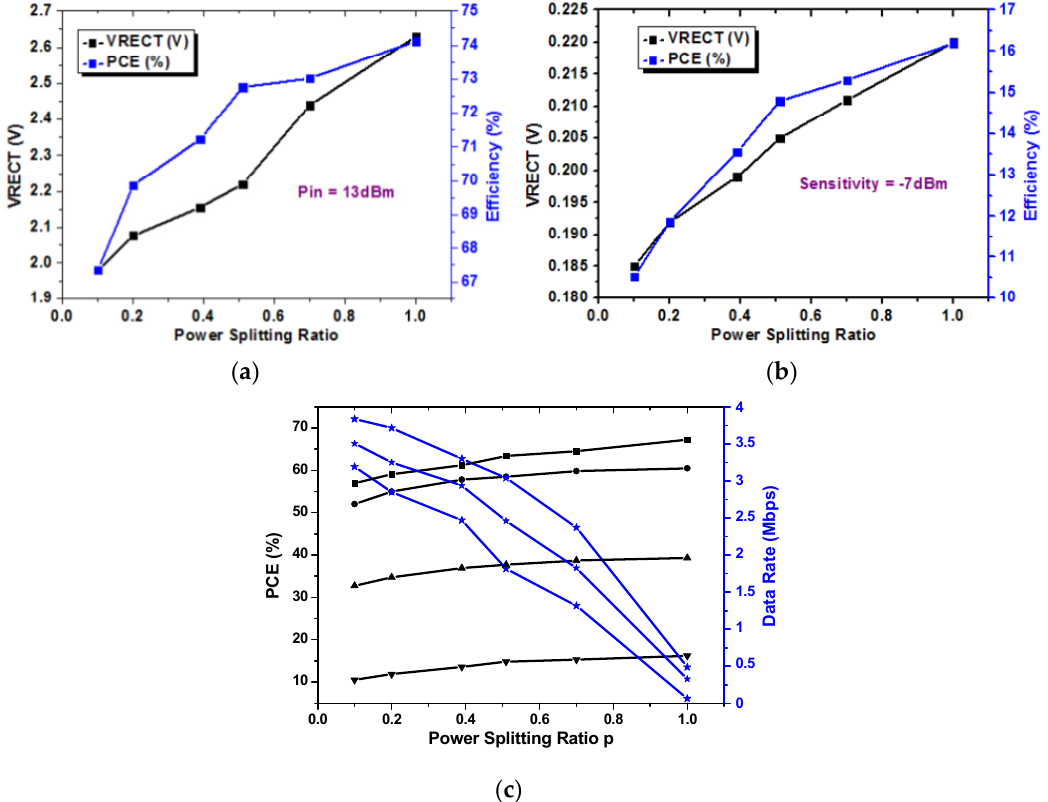
Figure 12. Measured PCE and output voltage of the rectifier ( V RECT ) of a single-stage RF–DC